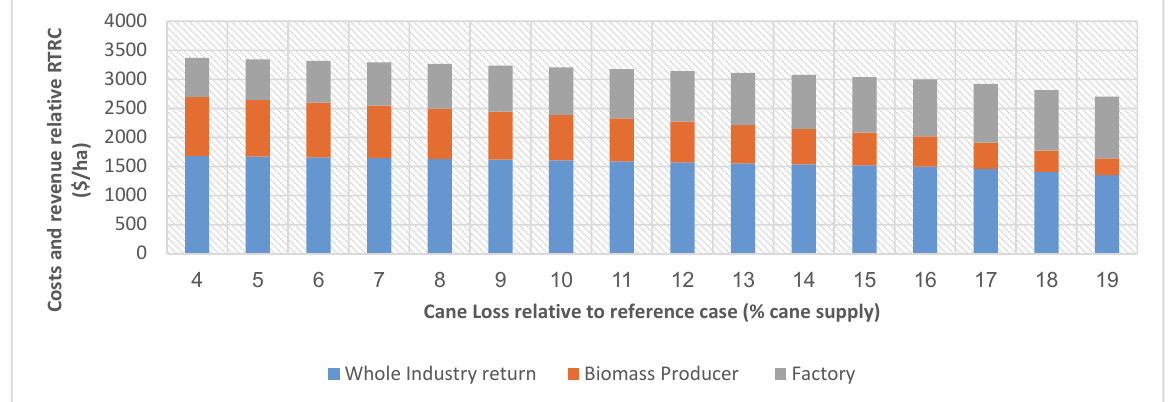
Fig. 7. Effect of changes of relative cane loss on industry sector relative return ($/ha)